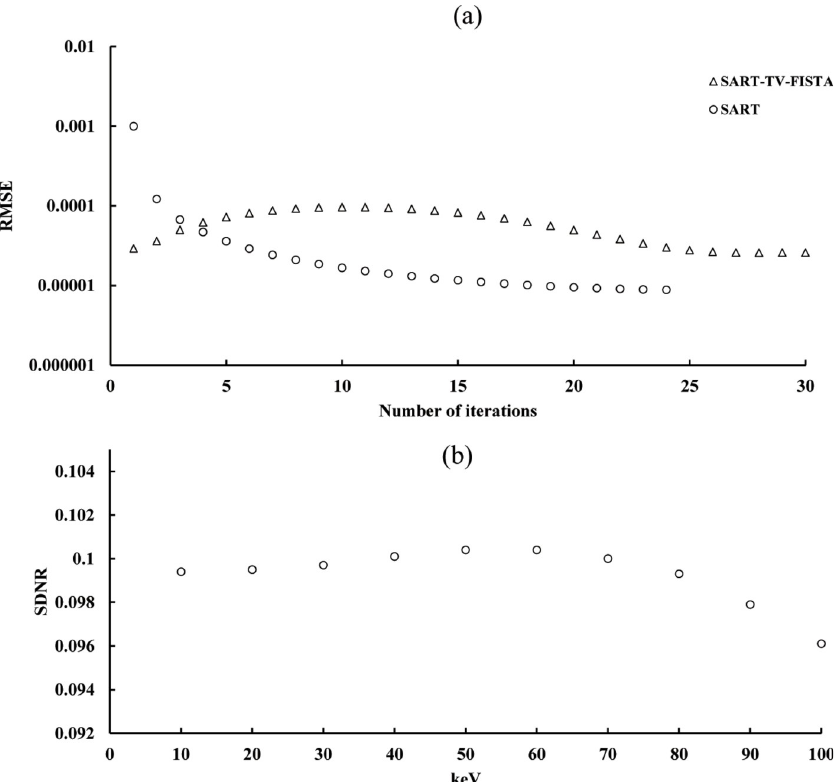
Fig 7. Optimization results for parameter [number of iterations for Iterative Reconstruction (IR) and Dual- Energy Virtual Monochromatic (DE–VM) energy] determination. (a) The root-mean square error (RMSE) with respect to number of iterations are shown for each polychromatic IR algorithm. (b) The signal-difference-to-noise ratios (SDNR) resulting from differences in the DE–VM energy in the simultaneous algebraic reconstruction technique (SART) total-variation (TV) first-iterative shrinkage–thresholding algorithm (FISTA) [DE–VM–SART– TV–FISTA] are